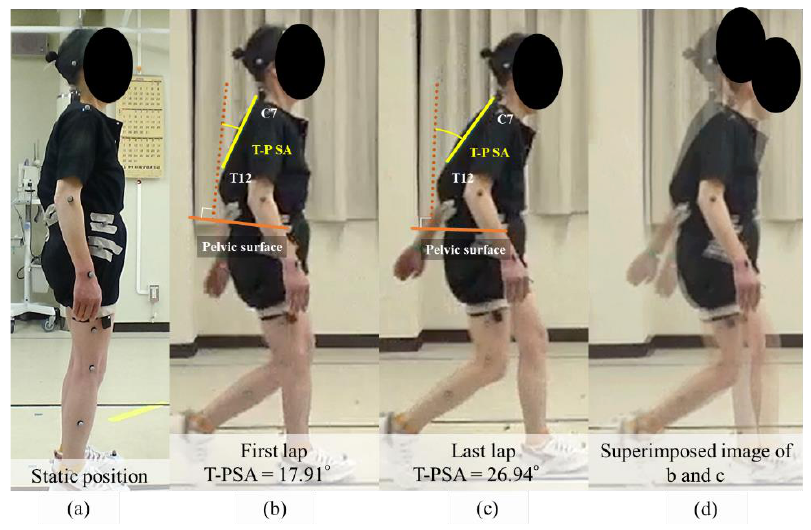
Figure 5. Gait analysis of representative case. This figure shows the posture during gait analysis.